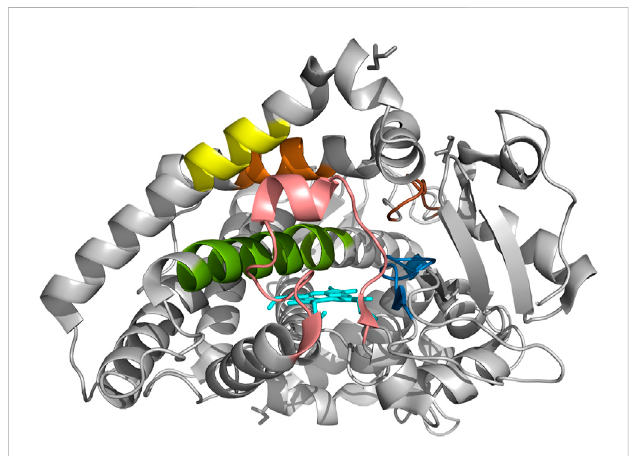
FIGURE 4 The crystal structure of CYP2C19 with six substrate recognition sites. Molecular structure of CYP2C19 was rendered by using the atomic coordinatesetPDB4GQS.SixSRSsareindicatedasfollows;SRS1inpink, SRS 2 in orange; SRS 3 in yellow, SRS 4 in green, SRS 5 in blue, and SRS 6 in brown. The heme is also illustrated